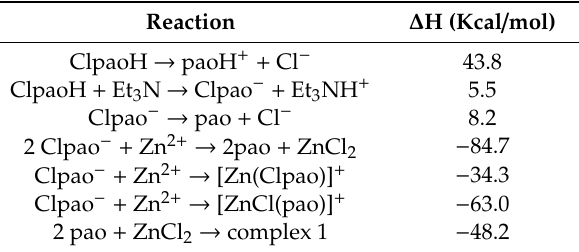
Table 4. Thermodynamics of possible reaction pathways involved in the reaction of ClpaoH with Zn(NO 3 ) 2 · 6H 2 O in solution (MeOH) in the presence of Et 3 N calculated at the PBE0 /